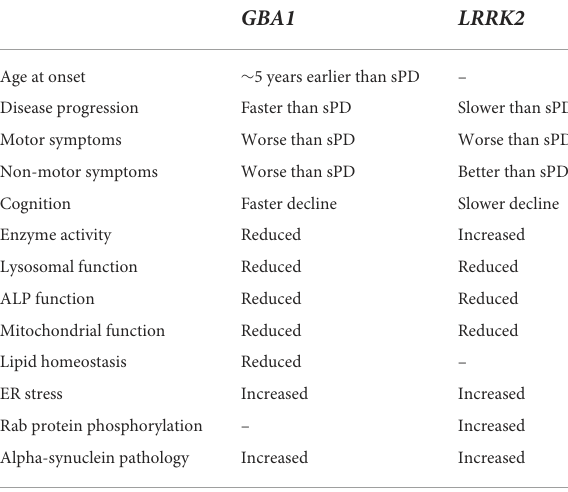
TABLE 2 Overview of the clinical presentation and pathological differences between GBA1 - and LRRK2- associated PD. GBA1